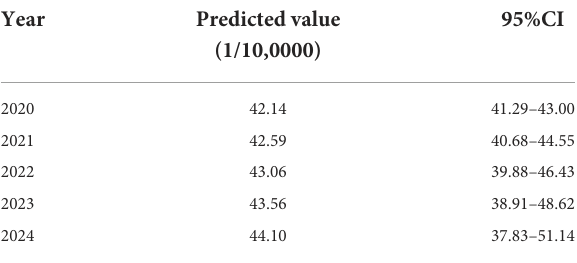
TABLE 5 The predicted values of ARIMA (0, 2, 0)